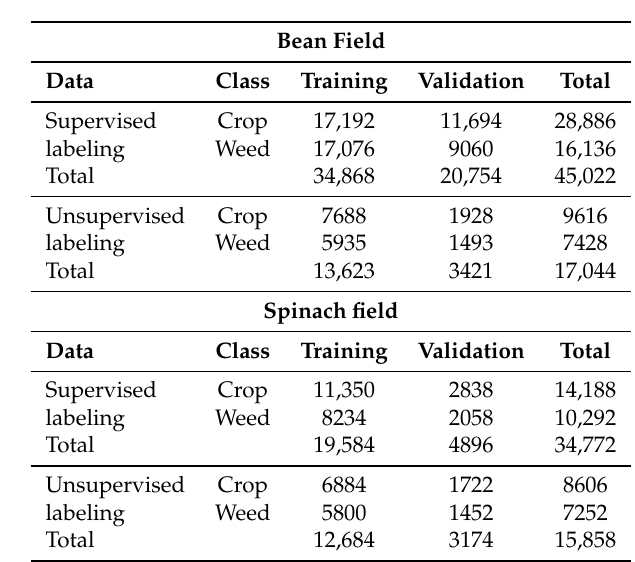
Table 1. Training and validation data in the bean and spinach